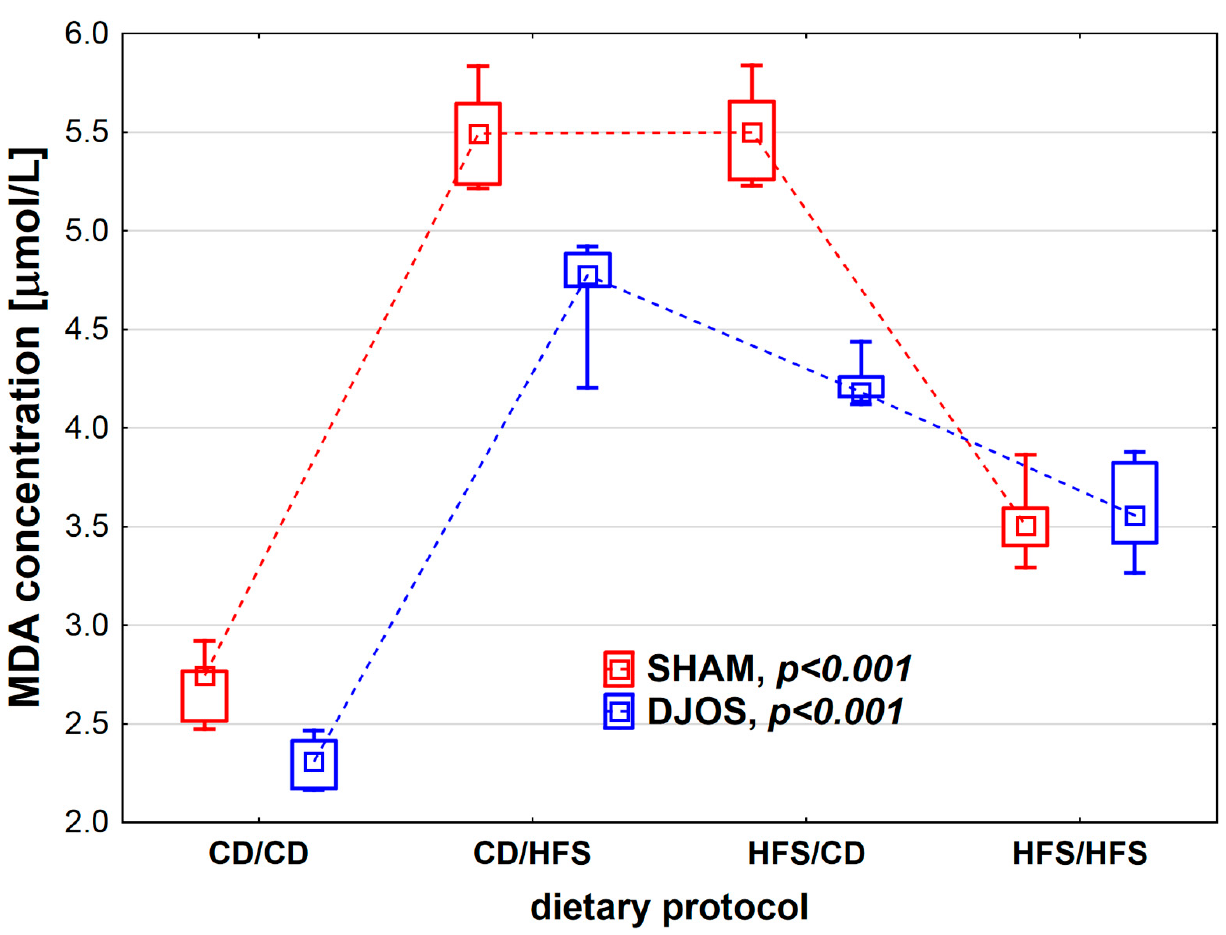
Figure 5. Malondialdehyde (MDA) concentration (µmol/L) in the plasma of Sprague-Dawley rats subjected to duodenojejunal omega switch (DJOS) and control (SHAM) surgery and different dietary protocols at 8 weeks after the surgery. Legend: CD—control diet, HFS—high-fat/high-sugar diet. The inner boxes represent the medians, the outer boxes represent interquartile ranges, and whiskers represent min–max range. For the reader’s convenience, the medians are connected with dashed lines.